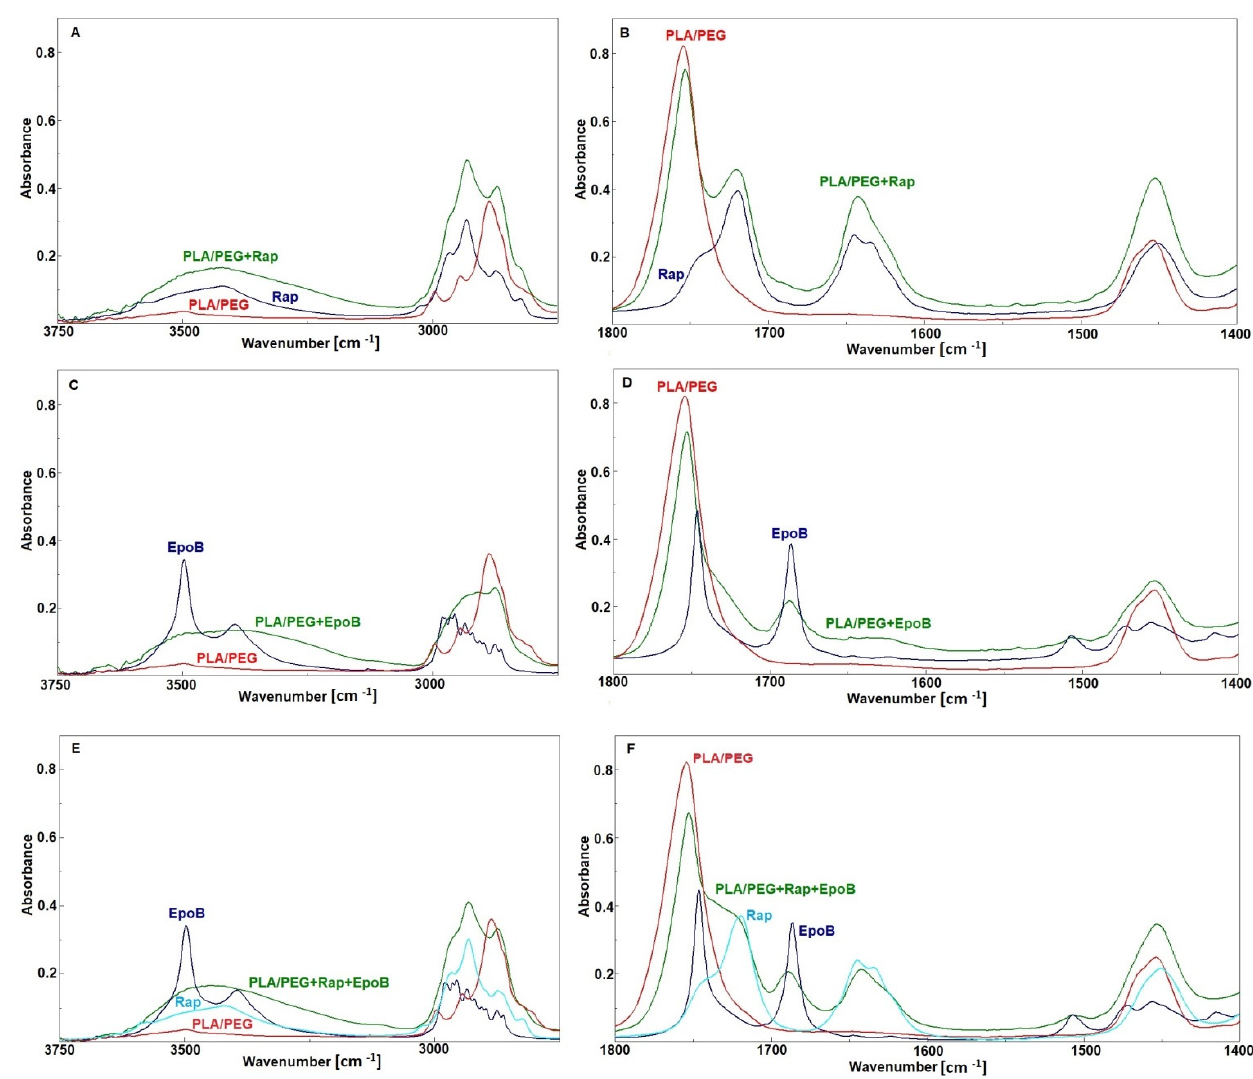
Figure 5. FTIR spectra of rapamycin (Rap), PLA–PEG, and PLA–PEG + Rap ( A , B ); epothilone B (EpoB), PLA–PEG, and PLA–PEG + EpoB ( C , D ); EpoB, Rap, PLA–PEG, and PLA–PEG + EpoB and Rap ( E , F ).